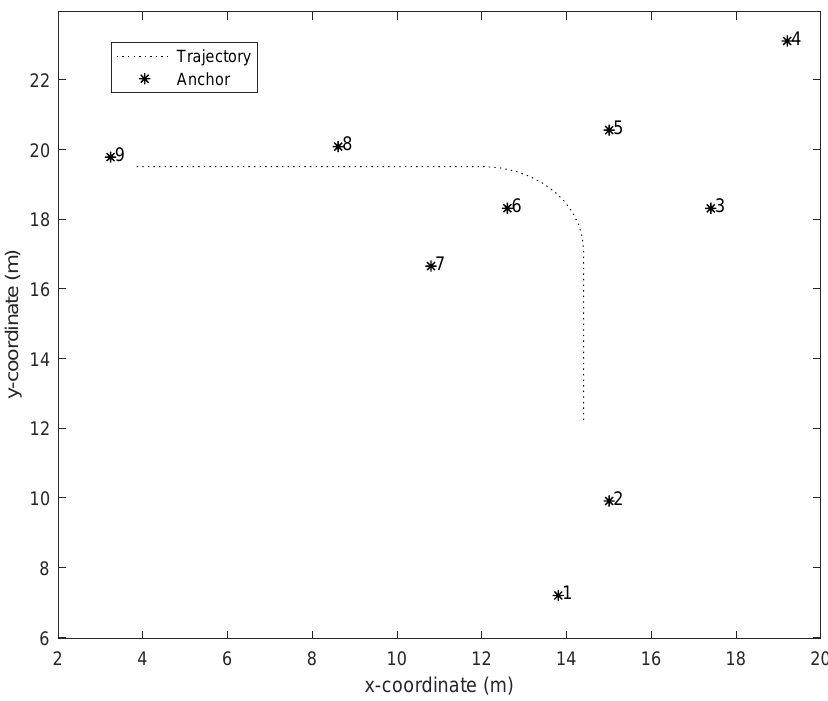
Figure 9. The robot trajectory and the position of anchors.